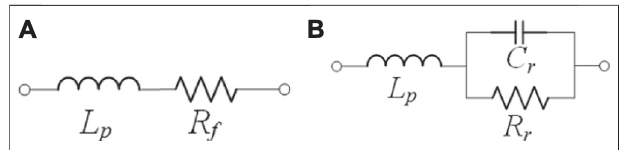
FIGURE 6 | Equivalent circuit models of the PIN diode (A) under the ON state and (B) under the OFF state.